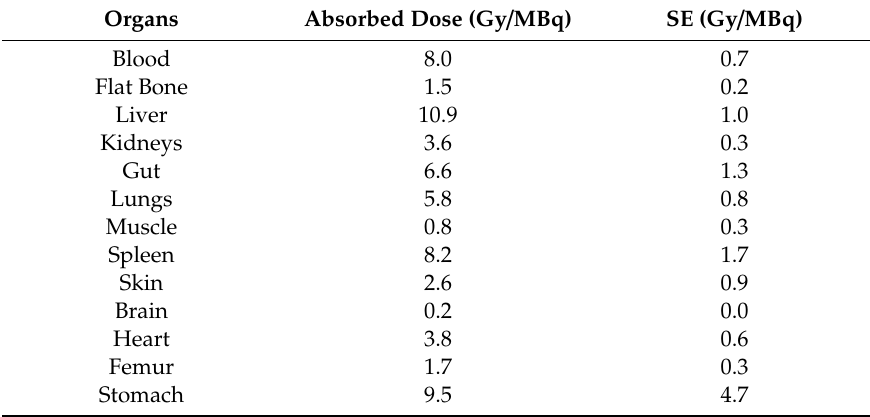
Table 2. 211 At-9E7.4 dosimetry study. Mean absorbed doses, expressed in Gy/MBq, and their standard error for the different organs.